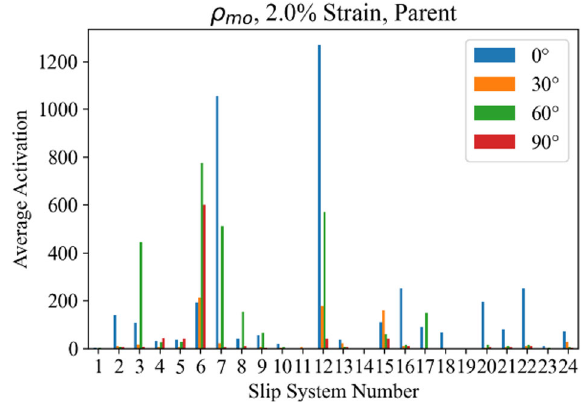
Fig. 17 Average mobile slip system activation for parent material (hcp) at 1.25% nominal strain.